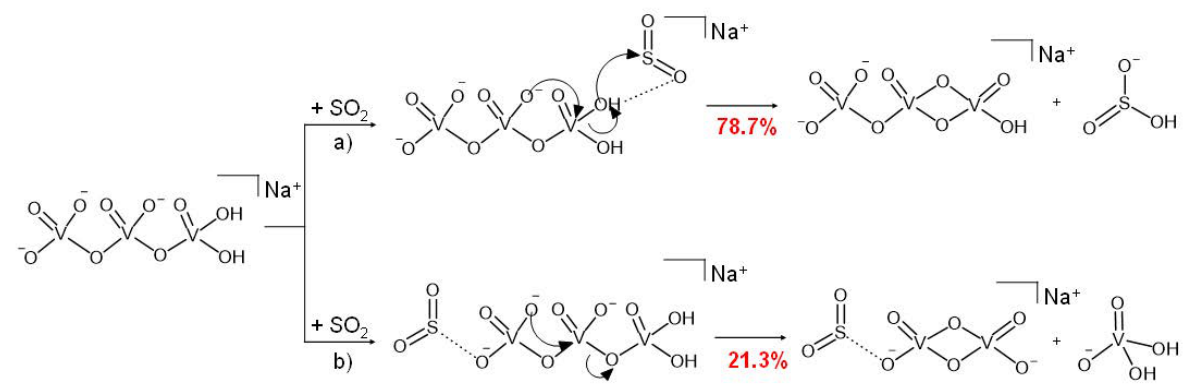
Scheme 3. Plausible reaction mechanism of H 2 NaV 3 O 102 − ions with SO 2 based on the corresponding kinetic